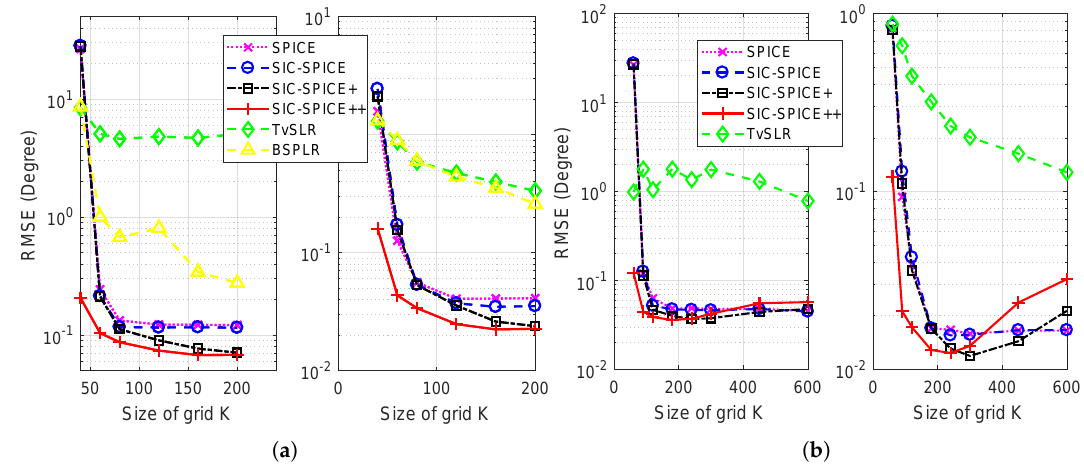
Figure 3. RMSE versus size of gird K with SNR = 20dB for the first ( left ) and third ( right ) sources. ( a ) N = 20, ( b ) N =